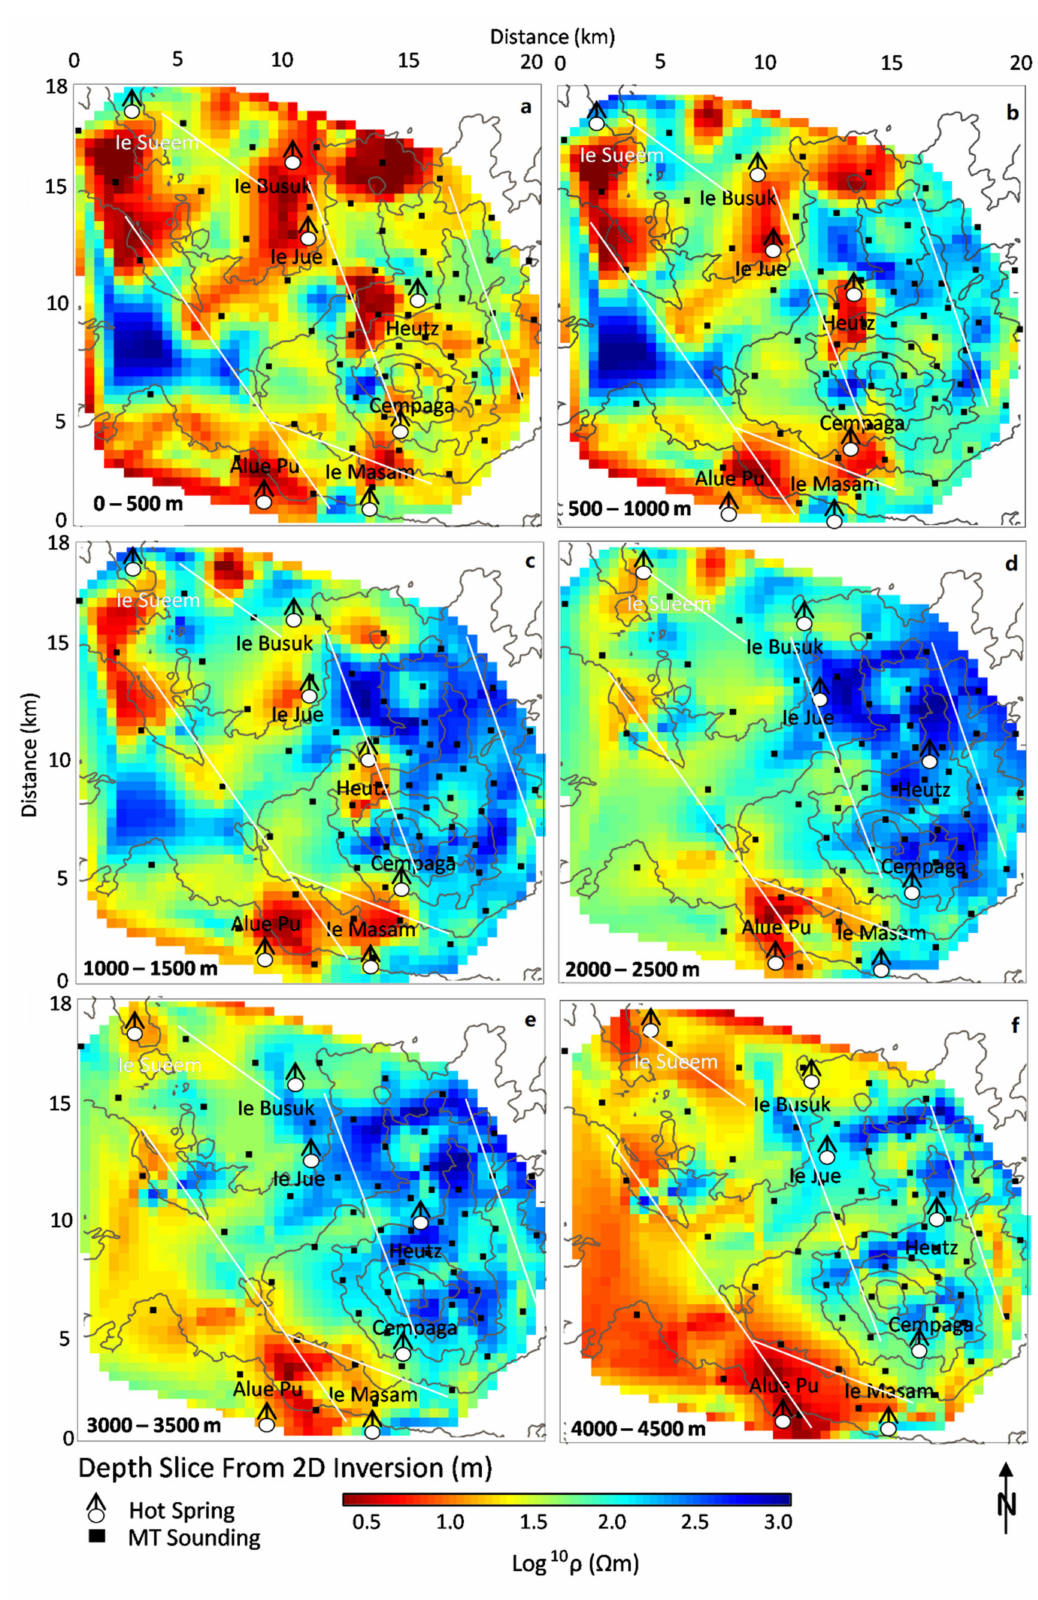
Figure 10. Depth slice of 3D resistivity combined from the results of the 2D inversion model on several paths. This 3D model was sliced at several depths, ( a ) 0–500 m, ( b ) 1000 m, ( c ) 1500 m, ( d ) 2000 m, ( e ) 3500 m, and ( f ) 4500 m, in view of mapping the fractures and hydrothermal flows in the volcano. The white line represents a local fault derived from Bennett et al.